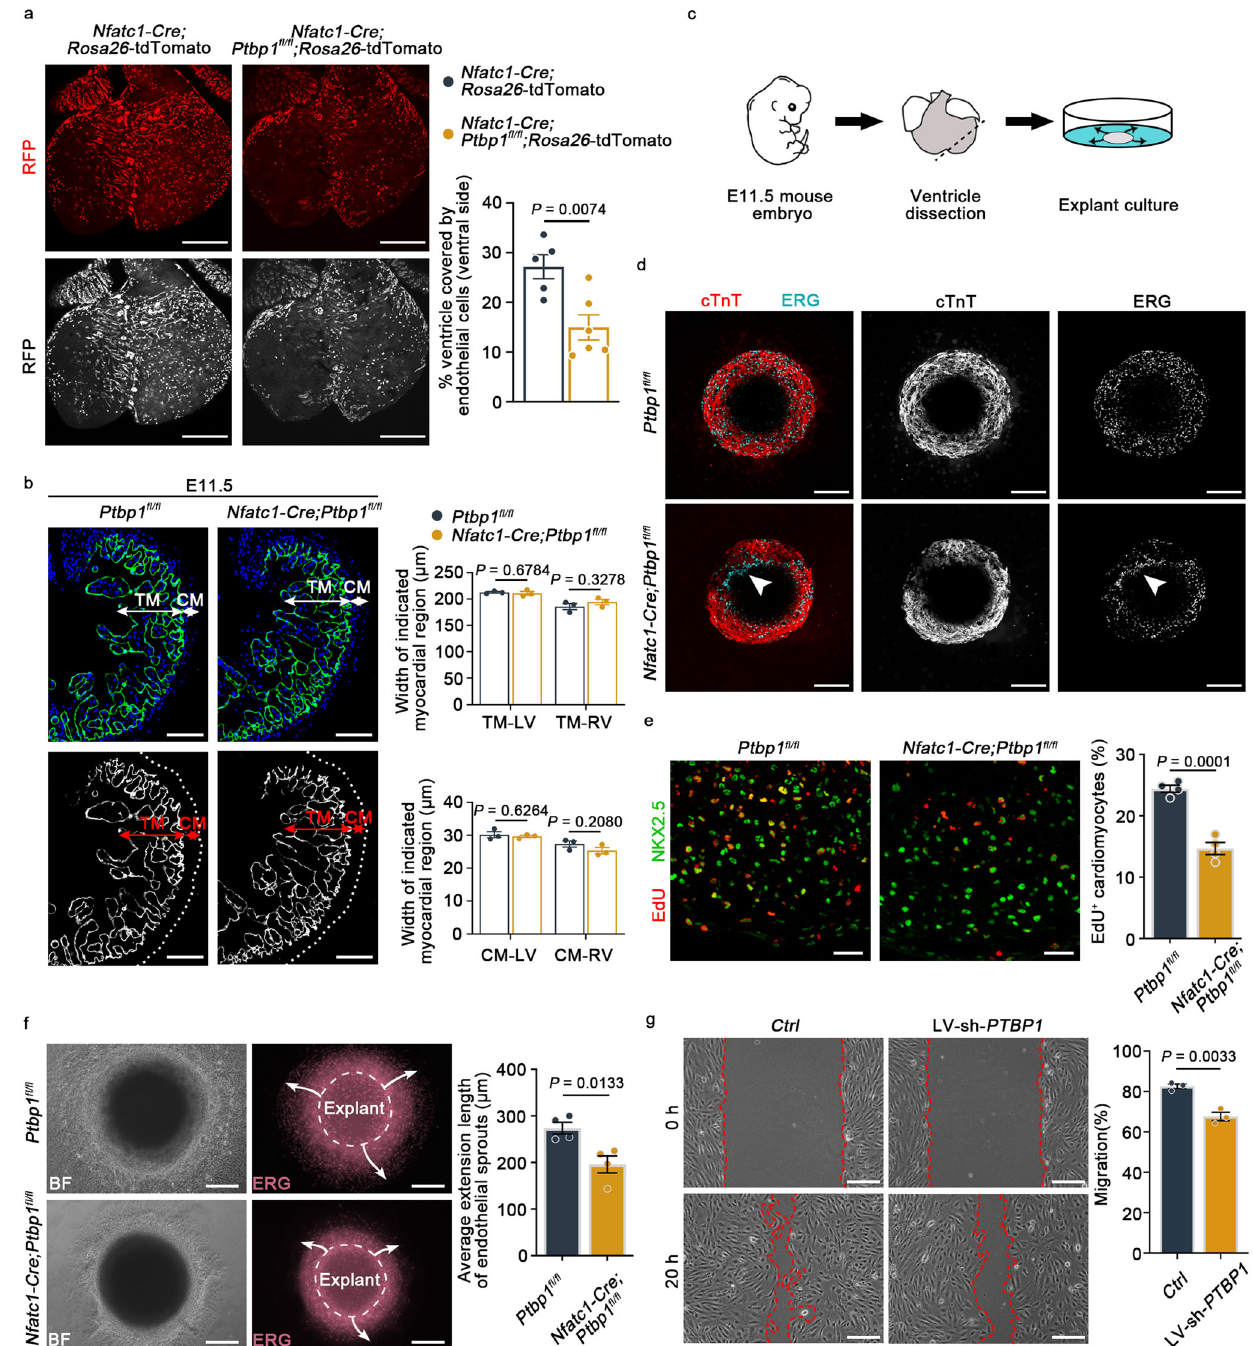
Fig.5| Ptbp1 knockdownaffectsendothelialcellmigrationandcardiomyocyte proliferation.a Representativeimagesandquanti fi cationshowingthesigni fi cantly decreased migration of endothelial cells (labeled with RFP) in E13.5 Nfatc1- Cre ; Ptbp1 fl / fl ; Rosa26 -tdTomato mice compared to Nfatc1-Cre ; Rosa26 -tdTomato mice, which were assessed by the percentage of endothelial cell coverage on the ventral side of the heart. Scale bars, 200 µ m. n =5 mice for Nfatc1-Cre ; Rosa26 - tdTomato group, n =6 mice for Nfatc1-Cre ; Ptbp1 fl / fl ; Rosa26 -tdTomato group. b Immuno fl uorescence staining of EMCN in heart sections from E11.5 Ptbp1 fl / fl and Nfatc1-Cre ; Ptbp1 fl / fl mice. Scale bars, 100 µ m. The graph shows the thickness of the compact myocardium (CM) and trabecular myocardium (TM) of E11.5 Ptbp1 fl / fl and Nfatc1-Cre ; Ptbp1 fl / fl mice. n =3 mice per group. c Schematic diagram showing the experimentalstrategyofexplantculture. d ImmunostainingforcTnT(red)andERG (cyan)inventricularexplantsfrom Ptbp1 fl / fl and Nfatc1-Cre ; Ptbp1 fl / fl miceafter2days culture. Scale bars, 200 µ m. The arrowheads indicate decelerated endothelial cell